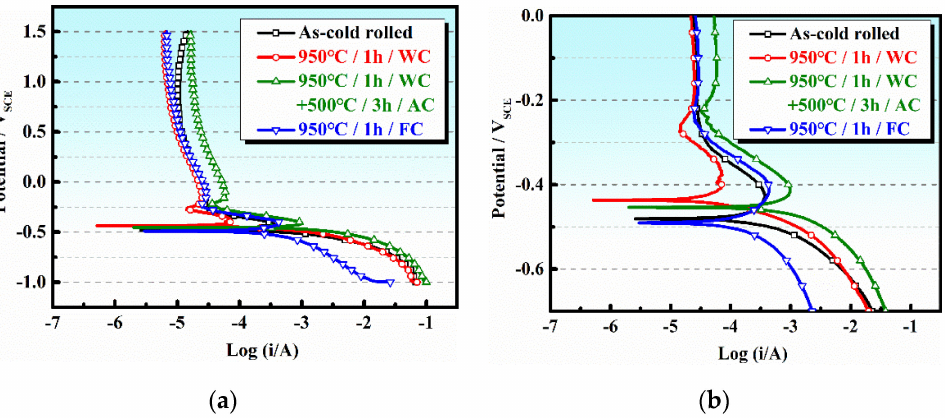
Figure 4. Potentiodynamic polarization of as-cold rolled and solid solution sheets in naturally aerated 0.5 M H 2 SO 4 + 5 ppm F − solution: ( a ) overall curves and ( b ) magnified curves near active region of each